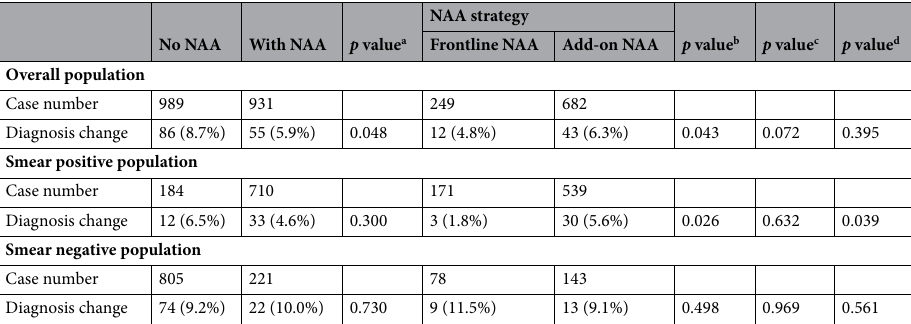
Table 5. Misdiagnosis in tuberculosis patients with and without NAA tests. Data are presented as n (%). NAA nucleic acid amplification, TB tuberculosis. a Comparison between patients with and without NAA tests. b Comparison between patients with frontline NAA and no NAA tests. c Comparison between patients with add-on NAA and no NAA tests. d Comparison between patients with frontline and add-on NAA